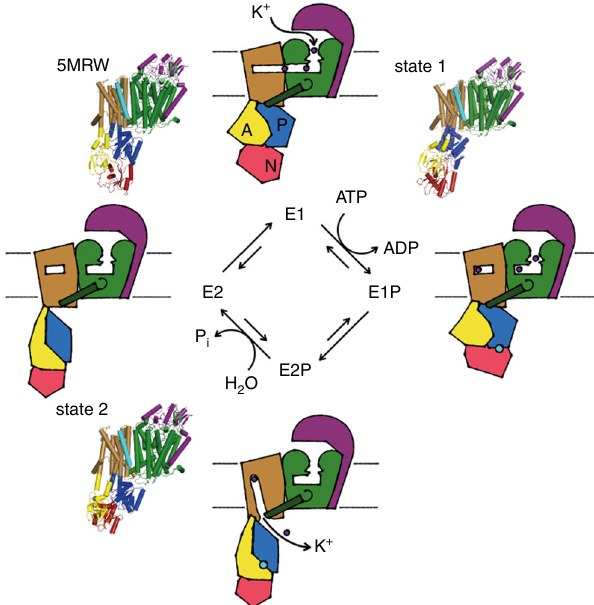
Fig. 5 Proposed transport cycle of KdpFABC according to a Post-Albers scheme. In the E1 state, the selectivity fi lter in KdpA selectively binds K + , from where it enters the outward-open half-channel by a tightly controlled knock-on mechanism. Once K + has reached its canonical binding site in KdpB, the tunnel closes at the interface of KdpA and KdpB occluding further passage of K + . Simultaneously, ATP is hydrolyzed to phosphorylate Asp307 in KdpB ’ s P domain (E1P). Rearrangements within the cytoplasmic domains bring the TGES motif of the A domain in close proximity to Asp307 in the P domain (E2-P). Here, the canonical binding site is distorted, the salt bridges between KdpA ’ s coupling helix and KdpB ’ s P domain are disrupted and the inward-open half-channel is formed triggering the release of K + into the cytoplasm. Dephosphorylation of Asp307 and P i release reset the transporter to the E1 state via an E2 apo-state. Structures of state 1 and state 2 as well as the crystal structure [5MRW] 4 are positioned at their presumed location in the reaction cycle. KdpA green with coupling helix dark green; KdpB sand with N domain red, P domain blue, A domain yellow and phosphorylated Asp307 cyan; KdpC purple; K + dark purple; KdpF is removed for